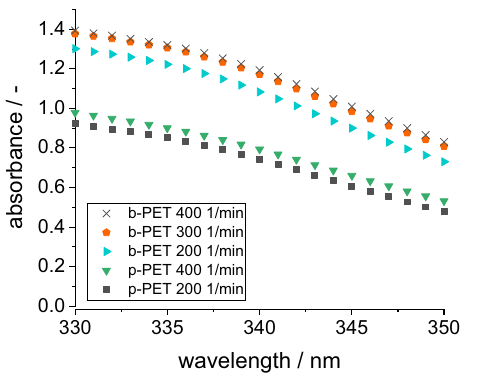
Figure 9: 1 H - NMR - Spectra of the obtained TA/IPA mixture from p - PET